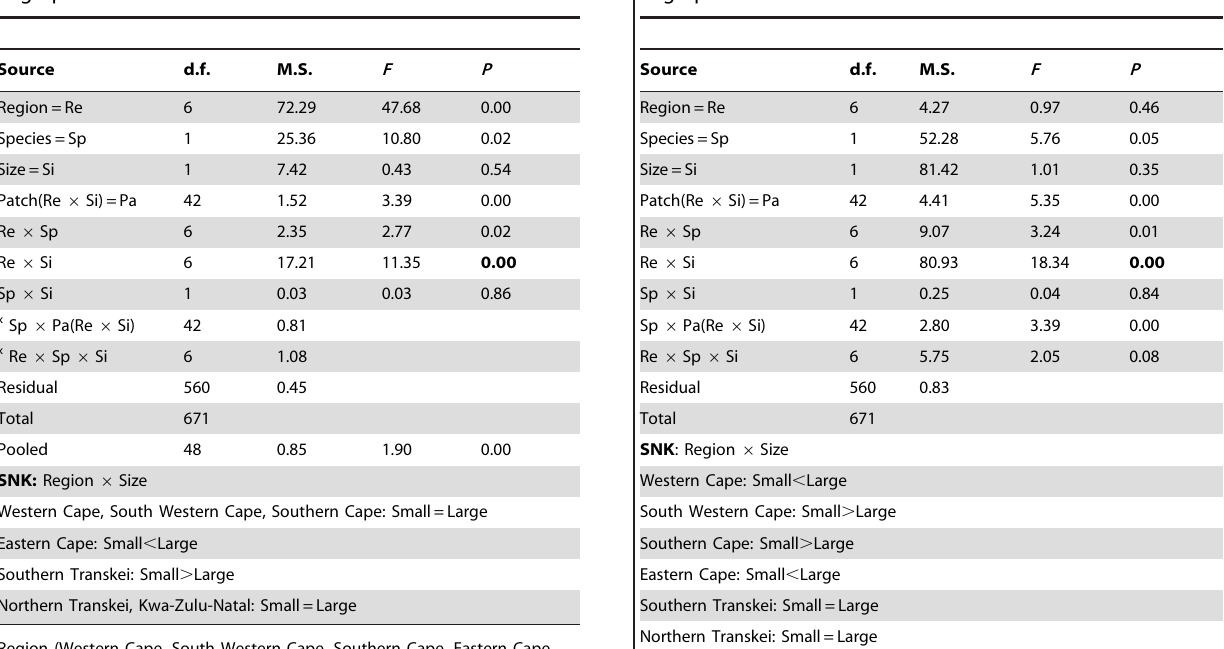
Table 1. Analysis of variance comparing densities of adult Siphonaria concinna and S. serrata in 7 regions along the 1500 km of the limpets’ biogeographic range in 4 small and 4 large patches.